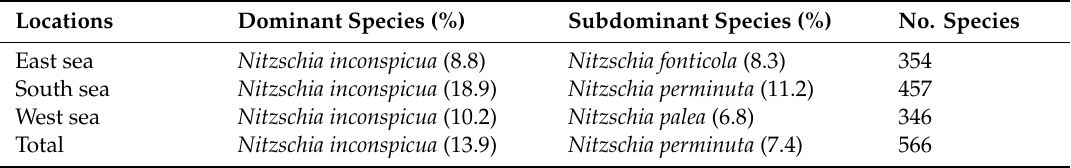
Table 2. Dominant species and number of species in Korean peninsula estuaries between 2009 and 2016.